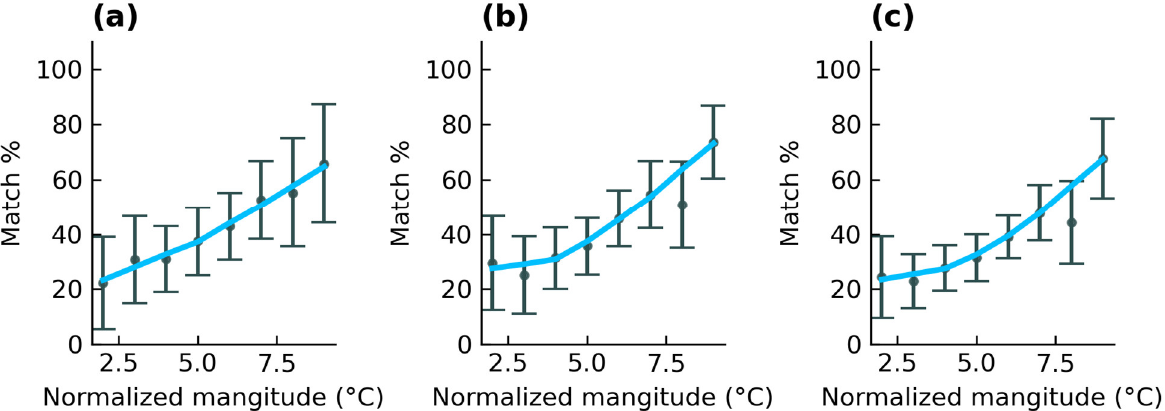
Figure 5. As in Figure 4, during nighttime.